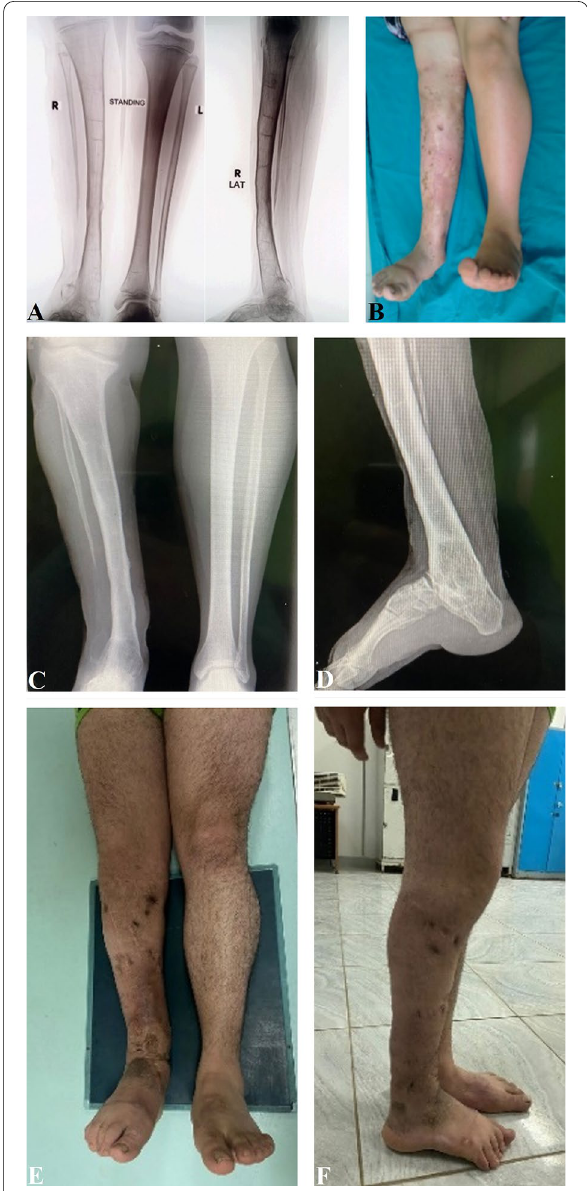
Fig. 4 Follow‑up X‑rays and clinical photographs of the same patient. A Five years’ follow‑up AP and lateral X‑rays showing overgrowth of the tibia by 4 cm together with valgus ankle. B Five years’ follow‑up clinical photographs. C Fifteen years’ follow‑up AP view showing varus deformity at the knee with depression of the medial joint space. There is also valgus deformity at the ankle with 1.5 cm shortening. D Lateral X‑ray of the leg and ankle shows total fusion of the ankle and subtalar joint and an increased calcaneal pitch angle. E , F Clinical photographs of the patient when he became 21 years